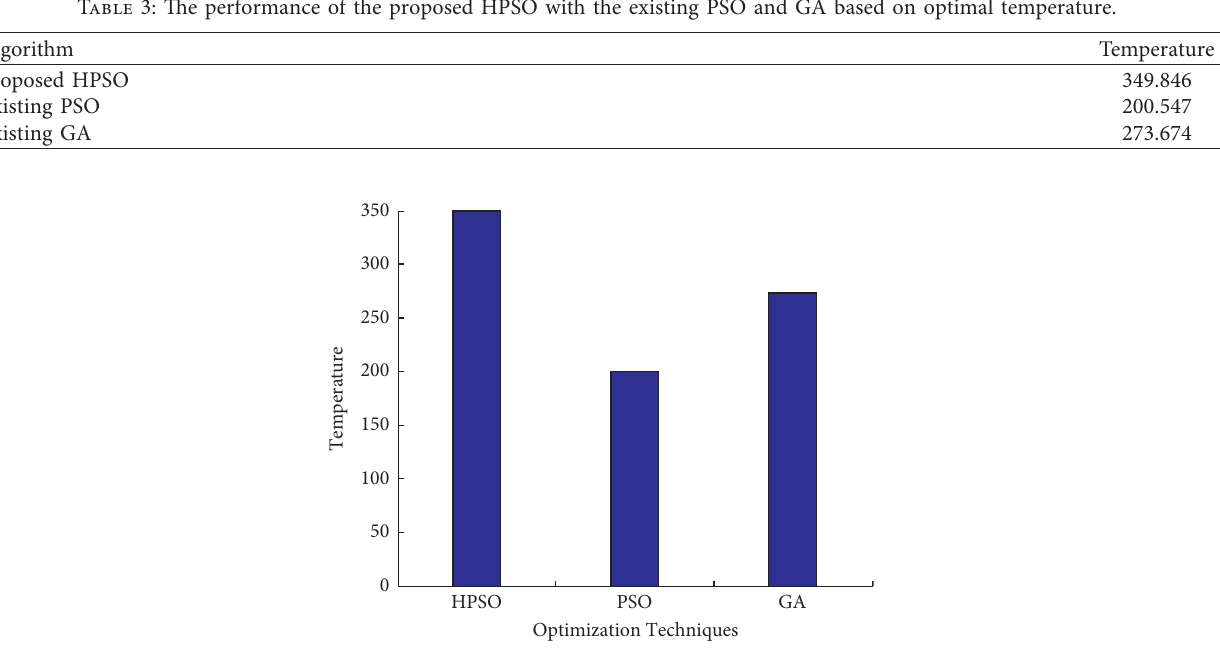
Figure 6: Performance of the proposed HPSO with existing PSO and GA based on optimal